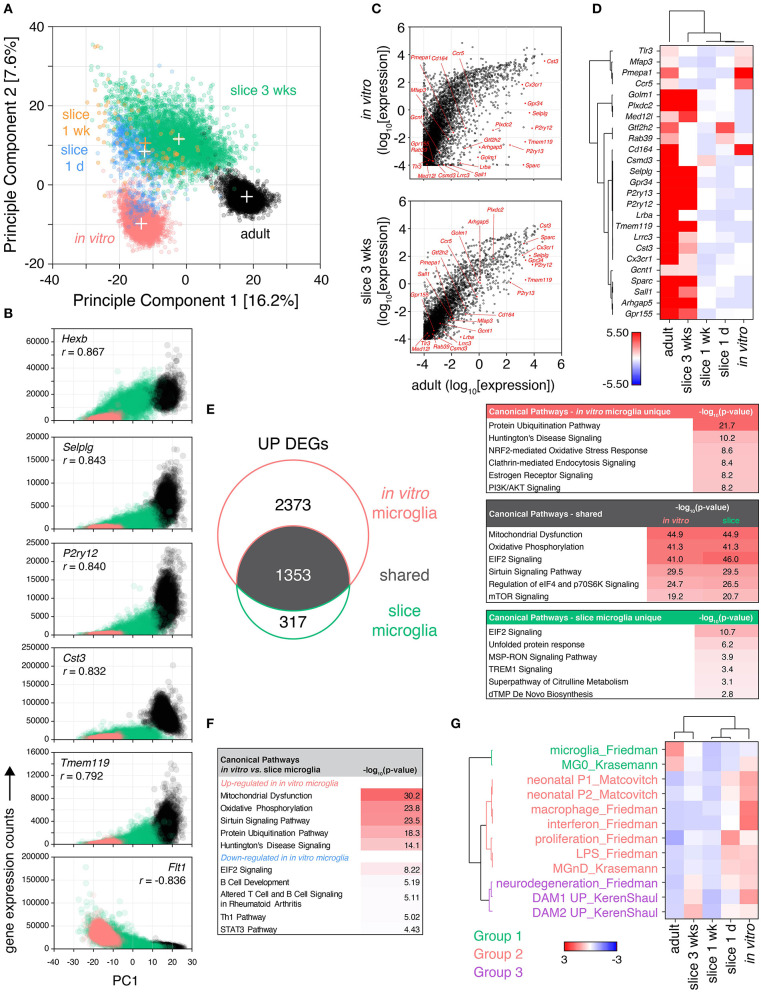
Microglia isolated from cultured brain slices share greater similarity to their adult in vivo counterparts than in vitro primary microglia. Brain slice culture, in vitro primary/mixed glial culture and freshly-isolated adult microglia were isolated by FACS and subjected to single cell RNA expression profiling. (A) PCA was performed to determine similarity between cells. “+” indicate cluster centroids (PC1, PC2): in vitro (−13.5, −9.8), slice 1 day (−12.6, 8.5), slice 1 week [−12.4, 10.5; (orange) for clarity], slice 3 weeks (−2.3, 11.5), adult (17.1, −3.0). Each circle represents an individual cell, each cluster consists of cells from two independent samples. (B) Gene correlation vs. PC1 was performed comparing adult, in vitro and slice microglia at 3 weeks to provide insight into genes associated with adult in vivo microglia phenotype; normalized gene expression relative to PC1 for the top 6 genes ranked by Pearson correlation coefficient (r) shown. (C) Mean absolute gene expression was determined for each cluster and compared between slice microglia at 3 weeks, in vitro microglia and adult microglia; microglia identity genes are labeled (Friedman et al., 2018). Each symbol represents an individual gene. (D) Heatmap representation of mean microglia identity gene expression (Friedman et al., 2018) between microglia clusters. Scale represents median absolute deviation by row (see Methods). (E) Up-regulated differentially expressed genes (UP DEGs) between either slice microglia at 3 weeks or in vitro microglia relative to adult microglia were compared. DEGs were subjected to Ingenuity Pathway Analysis to identify enrichment of the DEGs in canonical pathways. Top pathways ranked by p-value shown for DEGs shared or unique to slice 3 weeks and in vitro microglia, relative to adult microglia. (F) Pathway analysis was performed separately for genes up-regulated and down-regulated in in vitro microglia relative to slice microglia at 3 weeks, top five canonical pathways ranked by p-value for each shown. (G) Microglia transcriptional differences in culture over time were compared to published genesets associated with specific microglia states and phenotypes (Matcovitch-Natan et al., 2016; Keren-Shaul et al., 2017; Krasemann et al., 2017; Friedman et al., 2018). Geneset mean of z-score normalized gene expression. Sample microglia counts for 1 week slice microglia samples were 33 and 60 cells, while for other samples cell counts were 331–3,517 cells. Further analysis details contained in methods. See also Supplementary Figures 4, 5, and Supplementary Tables 4–6.